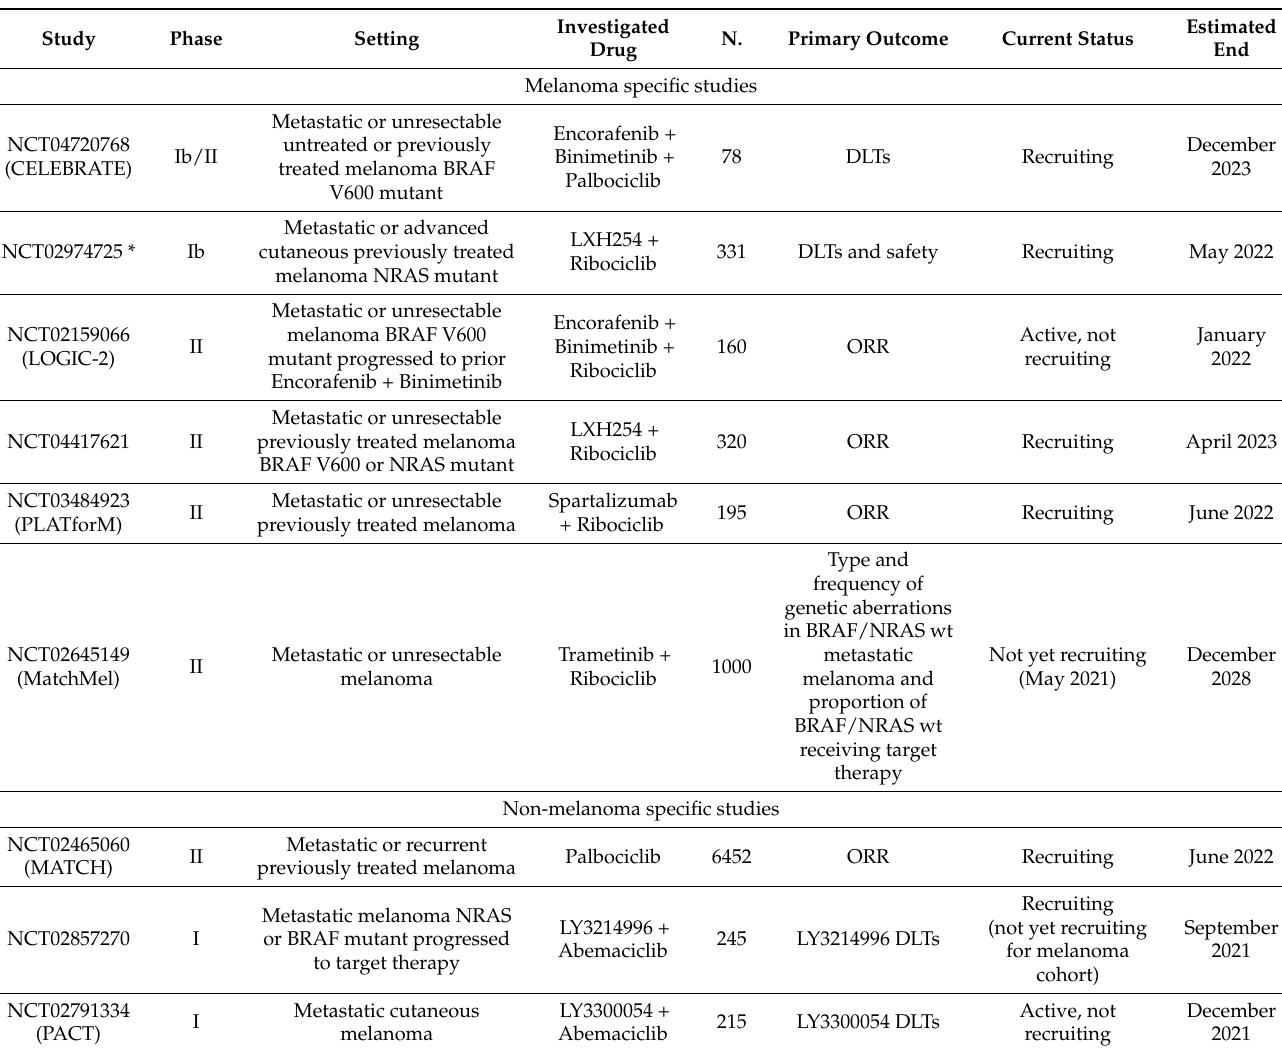
Table 3. Ongoing clinical trial with CDK4/6 inhibitors in melanoma. DLTs = dose listing toxicities; * melanoma and BRAF and KRAS mutant non-small cell lung